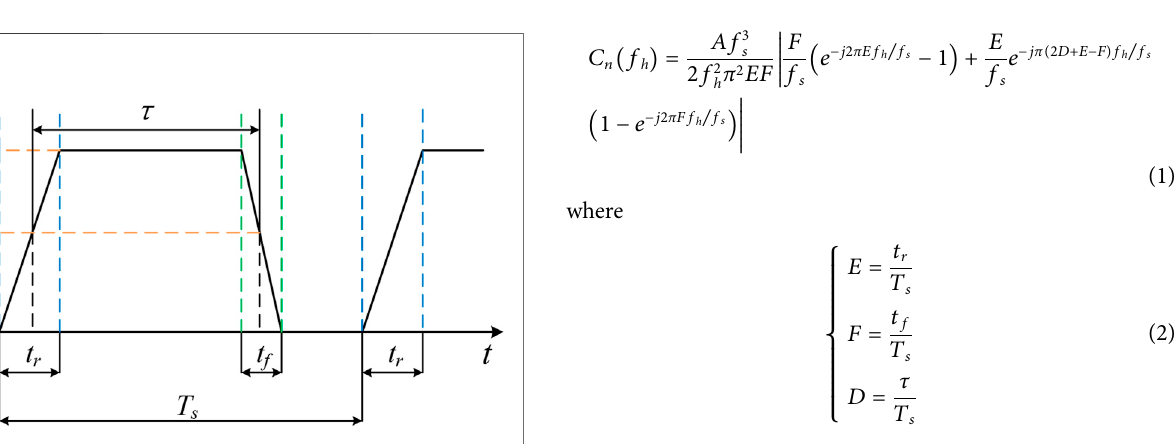
Frontiers in Electronics |